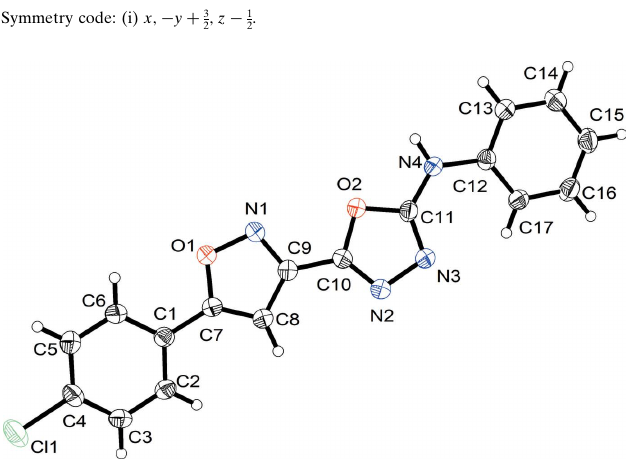
Figure 1 The molecular structure of the title compound showing 50% probability